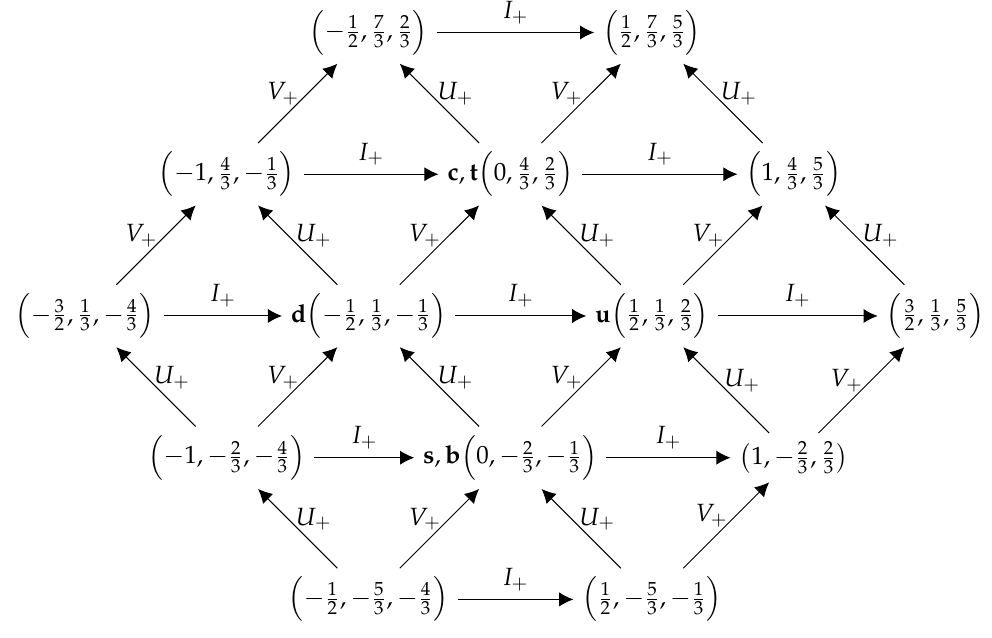
Figure 2. Diagram of 18